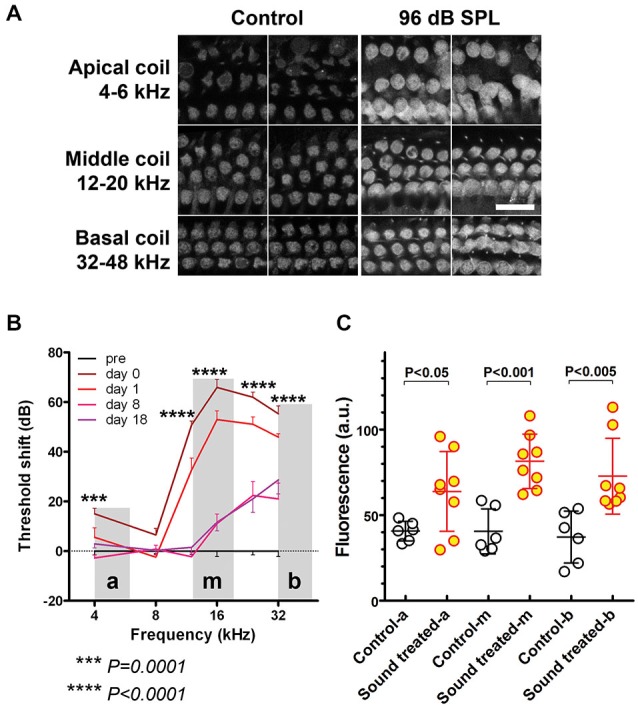
Regions with sound-enhanced GTTR uptake correspond to regions with TTS. (A) GTTR fluorescence in OHCs from apical, middle, and basal coils, representing 4–6 kHz, 12–20 kHz, and 32–48 kHz respectively, determined by the murine frequency-place map ImageJ plug-in.1 Scale bar = 25 µm. OHCs in loud sound-treated cochleae exhibited greater GTTR fluorescence compared to OHCs in all coils from control cochleae. (B) 96 dB SPL WBN resulted in a high-pass shaped TTS curve, minimal, yet significant, TTS at lower frequencies, i.e., 4–8 kHz, and TTS up to 70 dB at higher frequency regions, i.e., 12–32 kHz, using unpaired t-tests. “a”, “m”, and “b” depict apical, middle and basal cochlear regions respectively. Shaded areas depict cochlear regions where GTTR fluorescence was imaged and quantified. (C) WBN-induced sound-enhanced GTTR uptake is statistically significant at all examined frequency regions, using unpaired t-tests. Mean and s.d. are superimposed on each dataset.